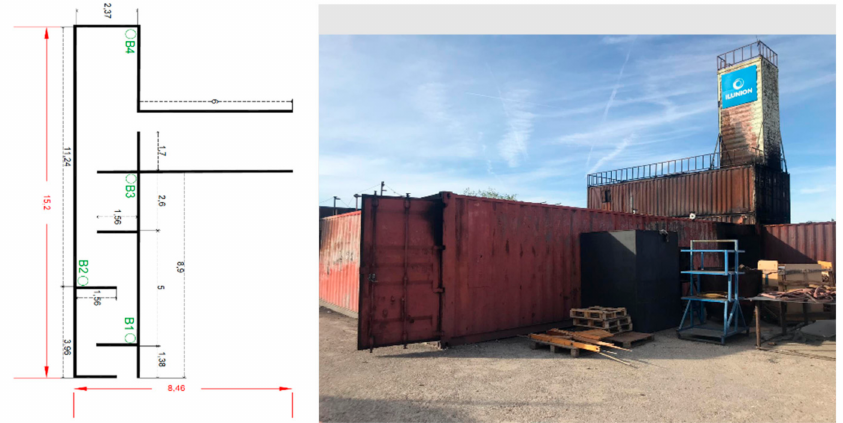
Figure 12. Representation of the MAP for the Teresa infrastructure evaluation and pictures of the